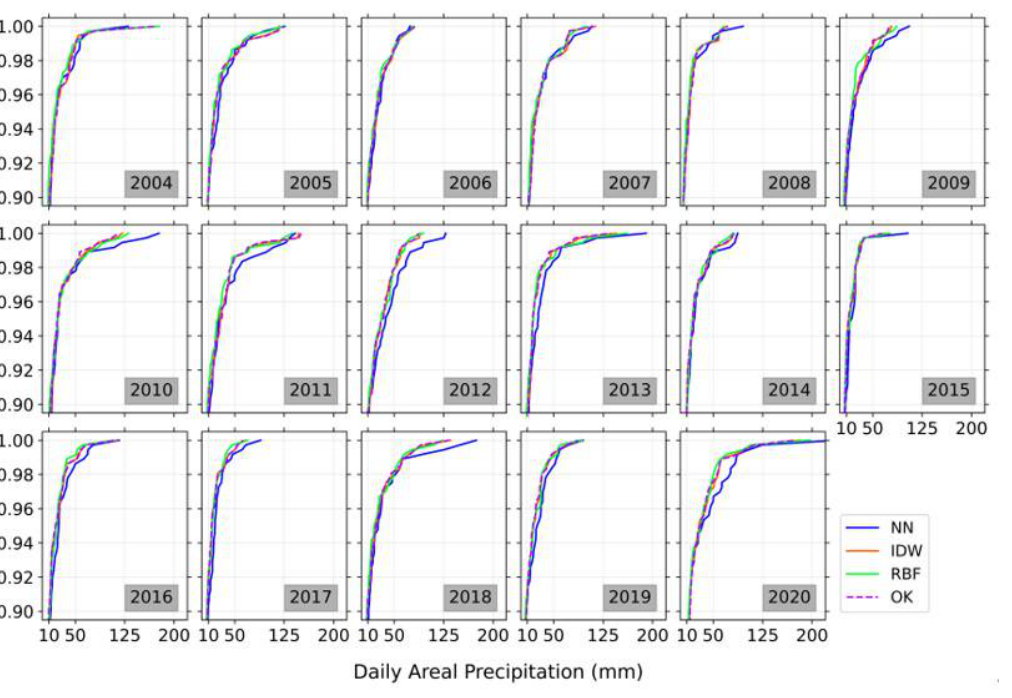
Figure 6. Comparison of occurrence frequencies of daily areal precipitation intensities based on four spatial interpolation methods from the year 2004 to 2020.